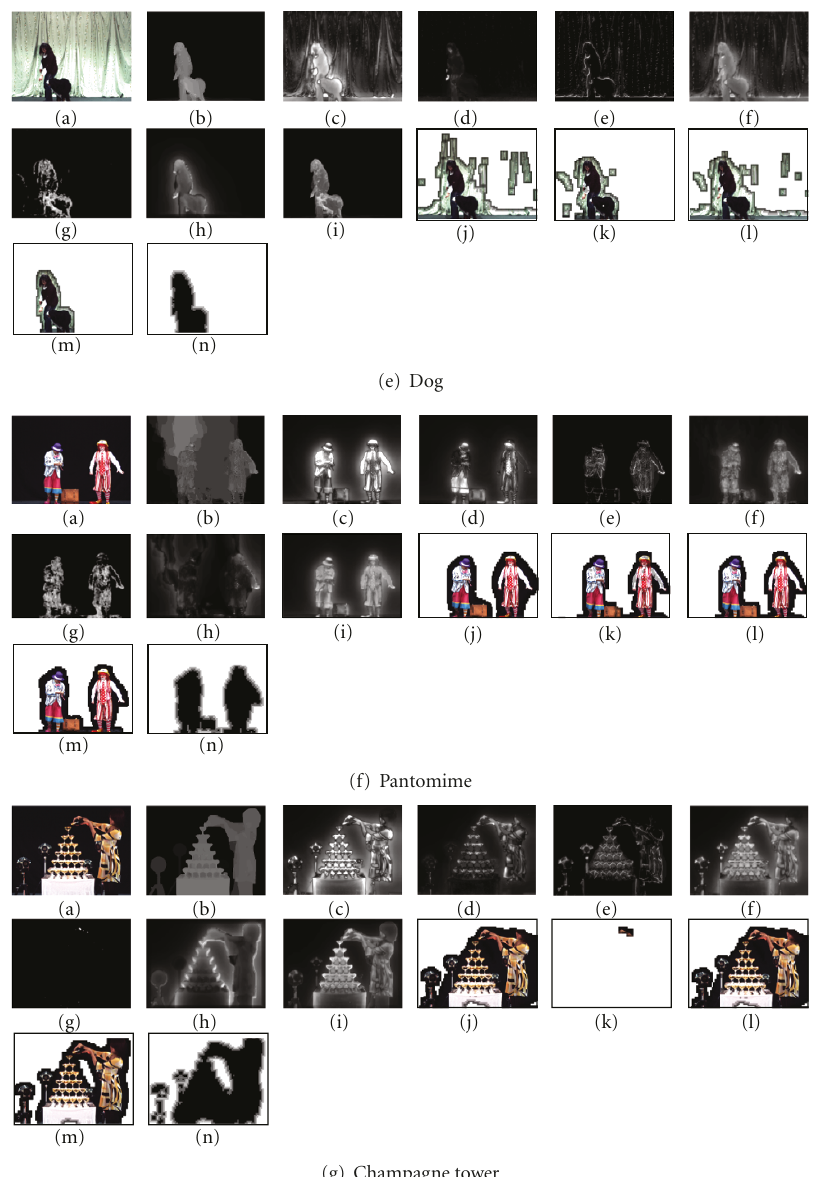
Figure 7: SVA-based ROI extraction results. (a) One view of original multiview video; (b) One view of multiview depth video; (c) Feature maps of intensity; (d) Feature maps of color; (e) Feature maps of orientation; (f) Static image saliency map; (g) Motion saliency map; (h) Depth saliency map; (i) Final SVA saliency map (proposed); (j) Extracted ROI using static image saliency (S-scheme); (k) Extracted ROI using motion saliency (T-scheme); (l) Extracted ROI using spatiotemporal saliency (ST-scheme); (m) Extracted ROI based on SVA model (proposed); (n) MB-level ROI mask